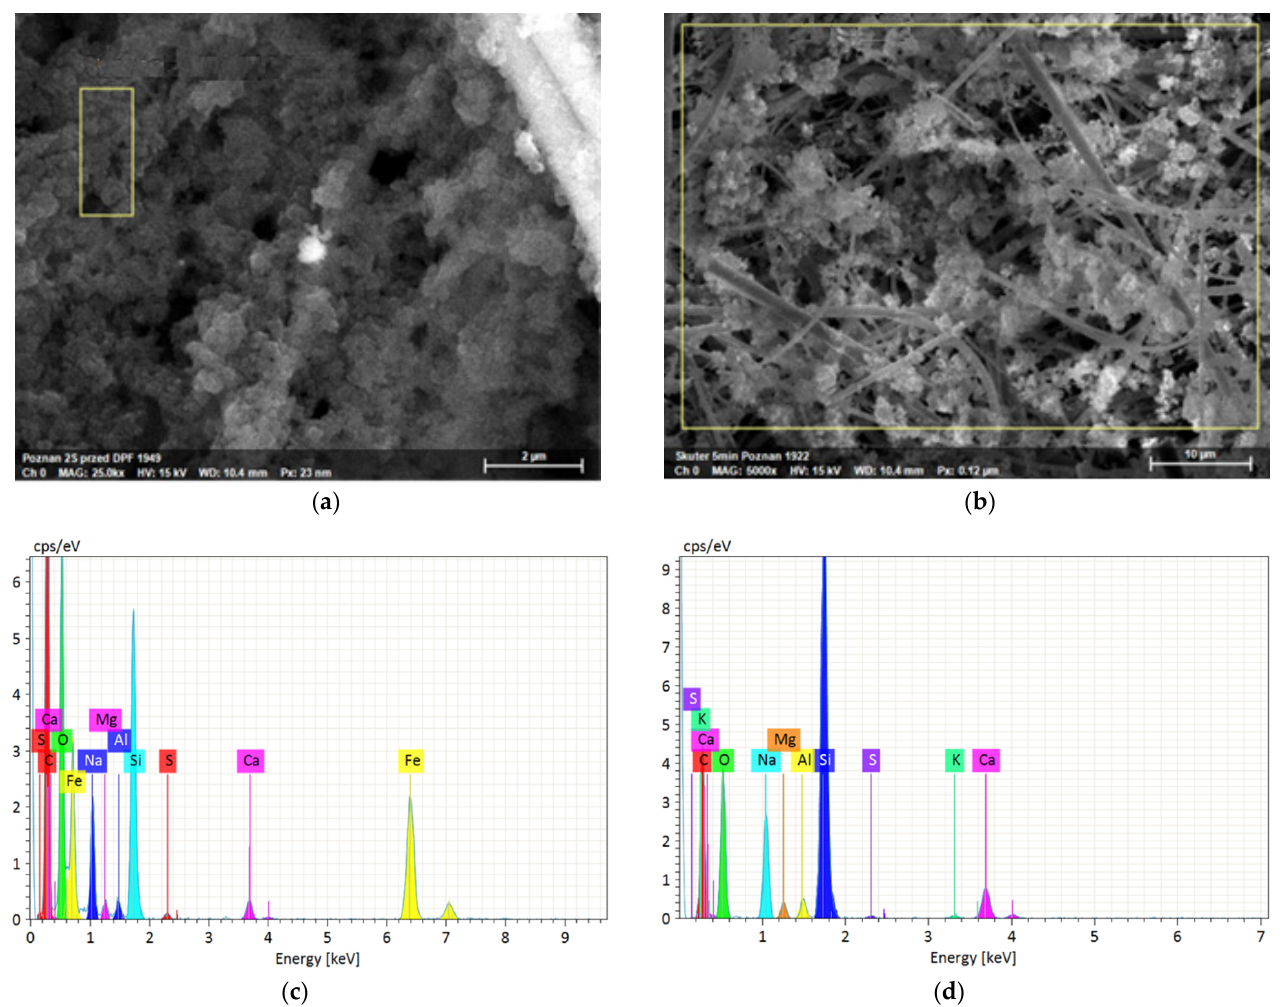
Figure 12. SEM micrographs for ( a ) Diesel engine and ( b ) petrol engine (scooter), showing area of EDS analysis. Elemental analysis for ( c ) Diesel and ( d ) scooter.